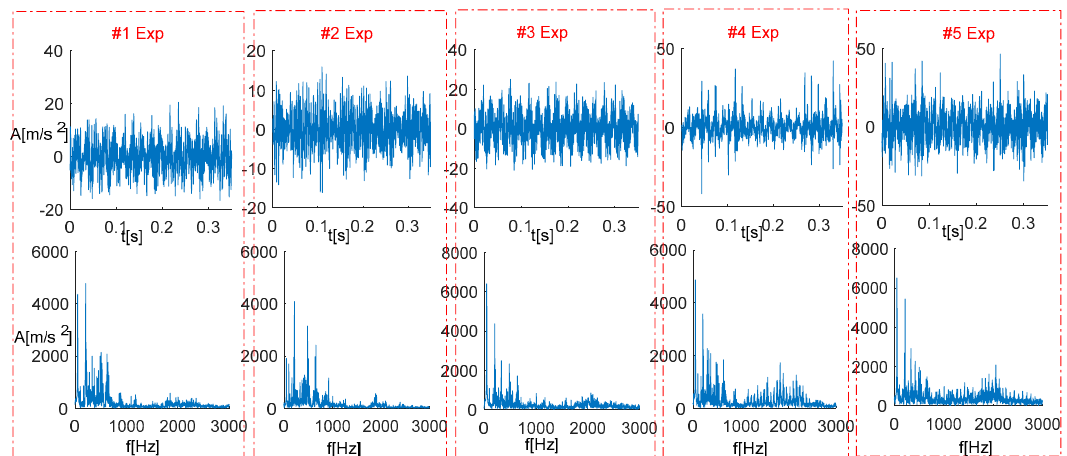
Figure 7. Vibration signals and their frequency spectra from experiments 1 to 5 (#1: a normal bearing; #2: a bearing with outer race defects; #3: a bearing with a pin roller defect; #4: a bearing with a cage defect; #5: a bearing with three kinds of coupling defects).